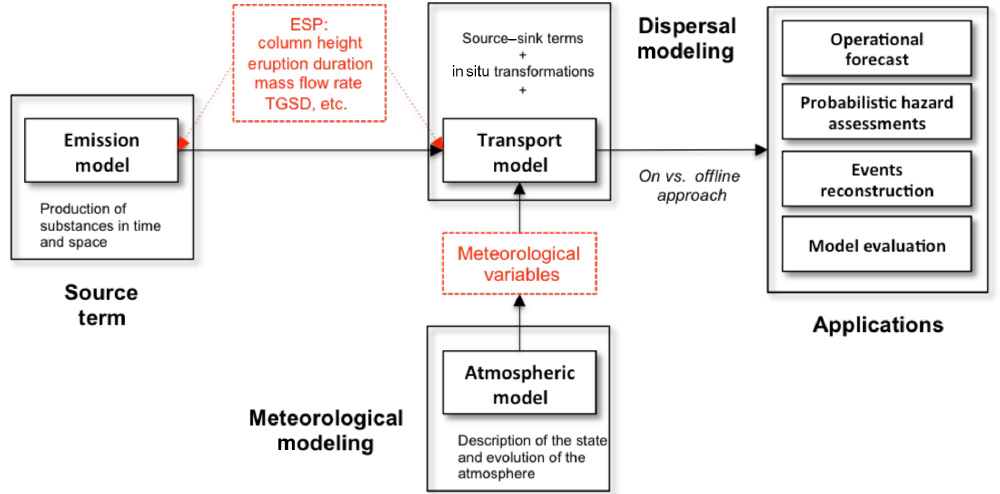
Figure 1. Schematic representation of the main components of an atmospheric transport model. Red text shows model specifications for the transport of volcanic